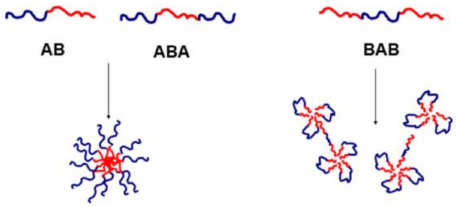
Figure 6. Schematic representation of AB, ABA and BAB copolymers of ethylene oxide (A block) and hydrophobically modified glycidol (B block) aggregates in